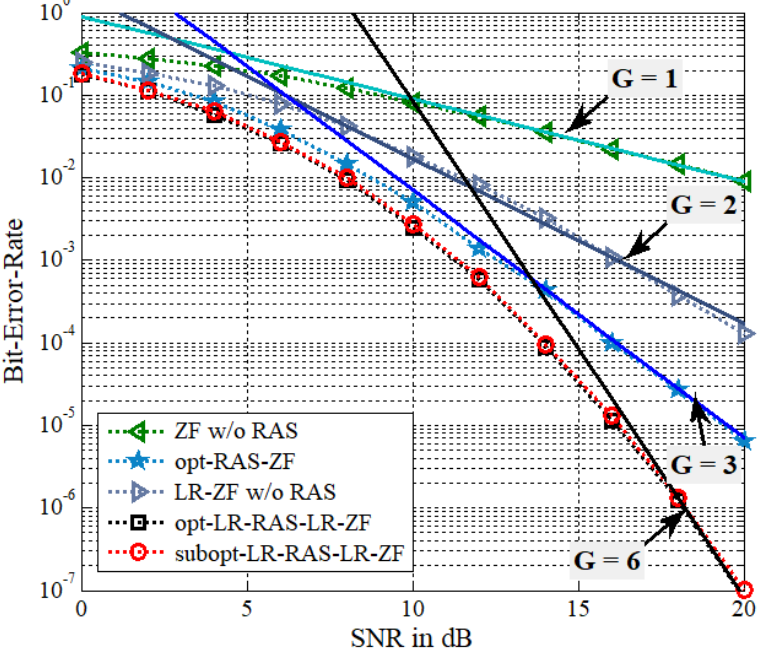
Figure 2. BER of the proposed algorithms for the LR-PSM system with N T = 2, N R = 4, and QPSK. In Figure 3, the BER performance of antenna diversity systems of (b), (d), and (e) with N T = 4 and N R = 5 is compared to that of (a) and (c) with N T = 4 and N R = 4. Figure 4 employs the same simulation setup parameters as Figure 3 except for N R = 6. Thus, the spectral efficiency is given as 4 bps/Hz. In the BER reference curves of Figure 3, the constants used for the diversity gains, G = 1, 2, 4, and 8, are c = 1.2, 2.3, 21, and 3.35 × 10 6 , respectively. In Figure 4, the diversity orders of G = 1, 3, 4, and 12, use the constants of c = 1.2, 5, 21, and 9.2 × 10 11 , respectively. It is seen that the LR-ZF-PSM without RAS selection outperforms the ZF-PSM without RAS selection, which is due to different diversity gain. That is, the LR-ZF-PSM without RAS selection can achieve the full transmit diversity of G = N T = 4 while the diversity gain of the ZF-PSM is only G = N T − N R + 1 = 1. Recall that no RAS selection implies that the scenario of N T = 4 and N R = 4. It is shown